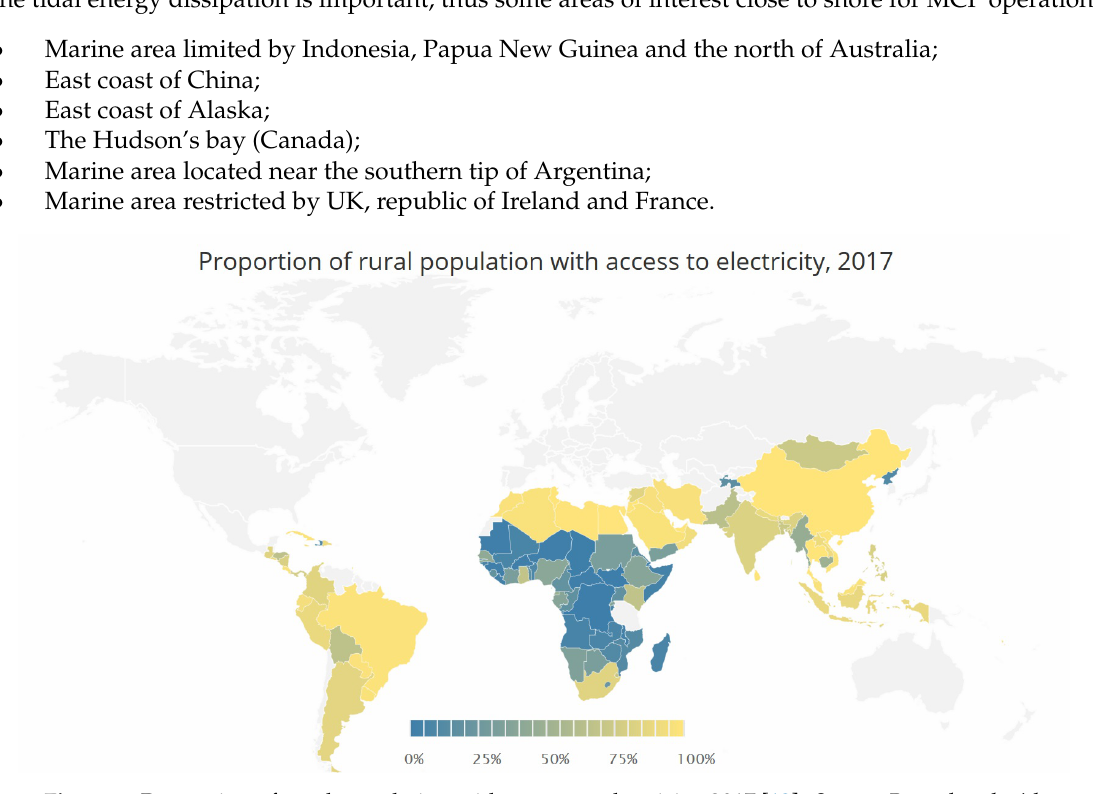
Figure 6. Proportion of rural population with access to electricity, 2017 [12]. Source: Reproduced with permission from IEA (2017) Sustainable Development Goal 7,